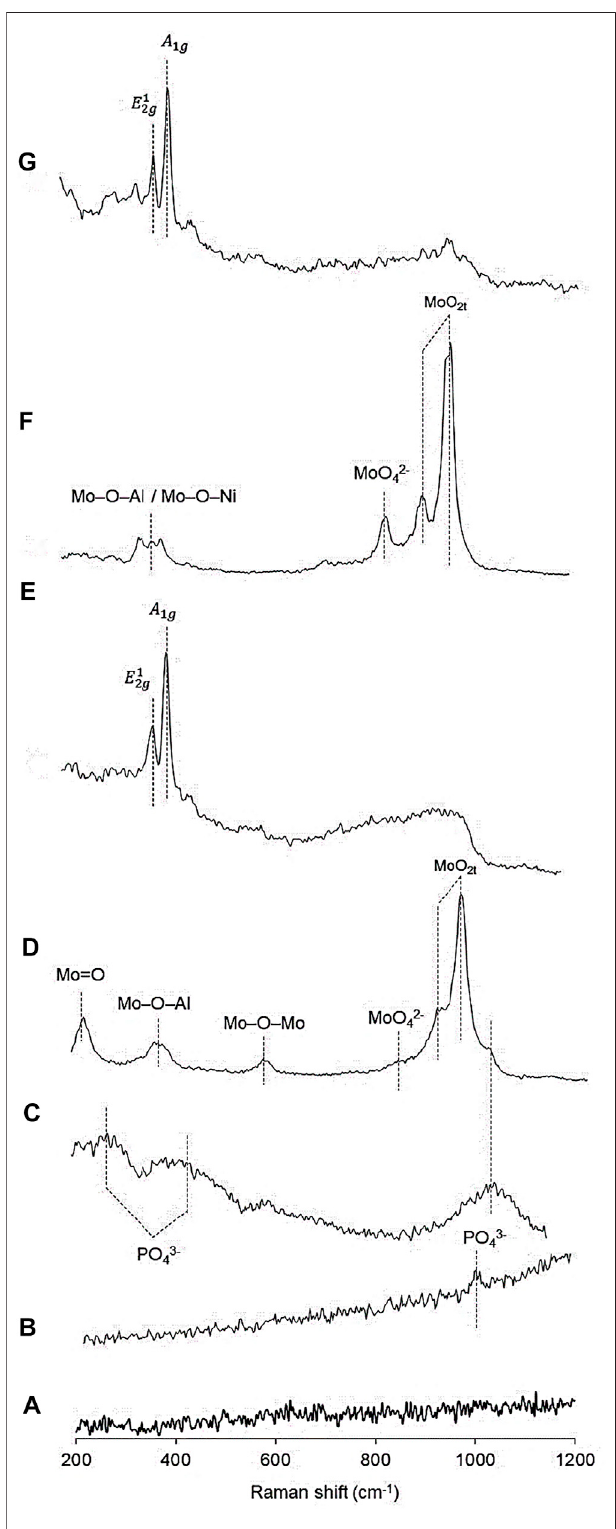
FIGURE 2 | Raman spectra of the Al 2 O 3 -MgO supported NiMo mixed phosphidic-sulphidic phase : (A) Al 2 O 3 -MgO, (B) NiP-O/ γ -Al 2 O 3 -MgO, (C) NiP-S/ γ -Al 2 O 3 -MgO, (D) MoP-O/ γ -Al 2 O 3 -MgO, (E) MoP-S/ γ -Al 2 O 3 -MgO, (F) NiMoP-O/ γ -Al 2 O 3 -MgO, and (G) NiMoP-S/ γ -Al 2 O 3 -MgO.